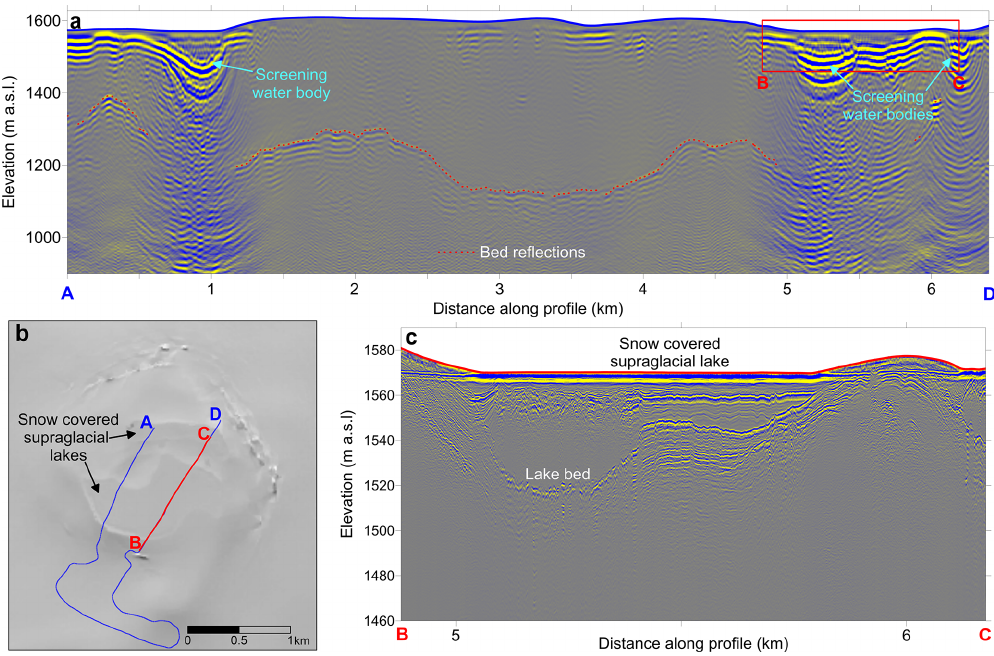
Figure 5. (a) The low-frequency (5MHz) RES survey (2D migrated) on 7 June 2017 from location A to D (location shown in panel b ) revealing features which induce ringing in the received radar reflections, completely screening reflections from the glacier bed (traced reflections indicated with a red dotted line). The flat glacier surface above these features along with the Landsat-8 optical image in August 2017 (b) clearly reveals these features as snow-covered supraglacial lakes. RES survey on 8 June 2017 with 50MHz Malå radar (c) along subsection B to C (location shown in panel b ) repeating the low-frequency survey (corresponding part of the low-frequency RES profile is indicated with red box in panel a ) further confirms this. Note that the elevation projection for panel (c) is carried out using c gl = 1 . 68 × 10 8 ms − 1 . The propagation velocity through the media above the supraglacial lakebed is much lower; hence the depth of the lake as indicated in panel (c) is overestimated. The vertical exaggeration is 2.5-fold and 5-fold in panels (a) and (c) ,